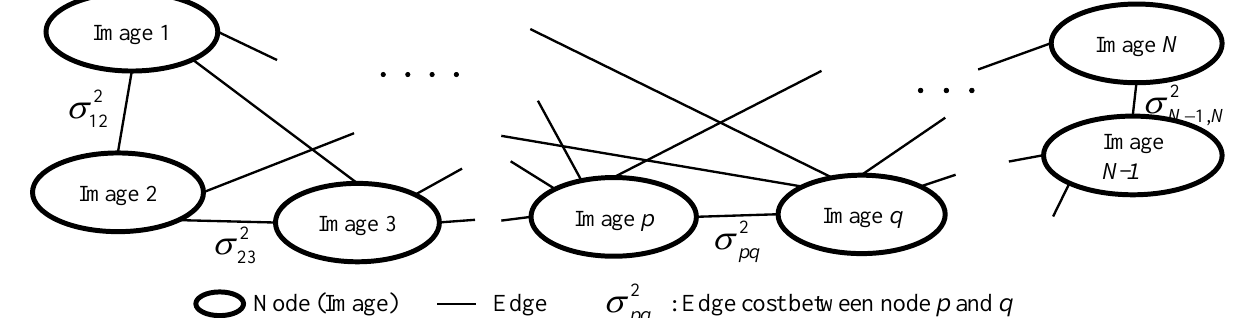
Figure 4. Image connectivity graph of image